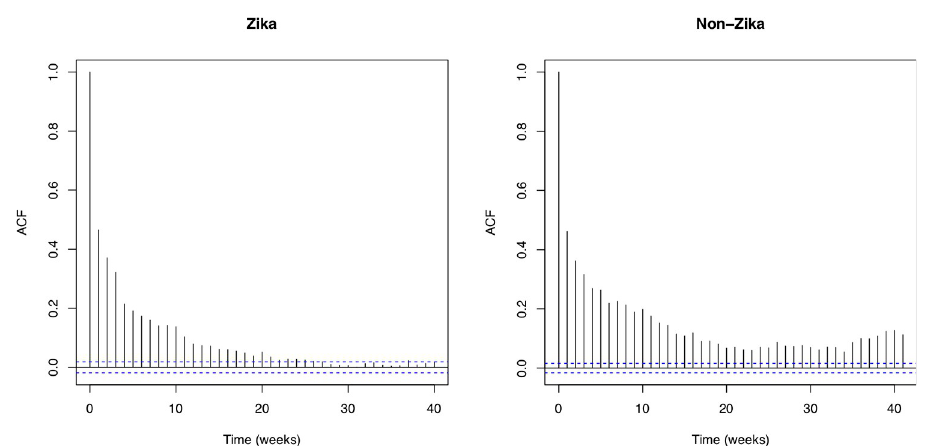
Fig 3. Temporal autocorrelation plot of average mosquito counts. These plots are shown over any one collection date for all traps in areas affected by Zika during the 2016 outbreak (left) and unaffected areas (right). Values outside of the blue-dashed lines are significantly different from zero.